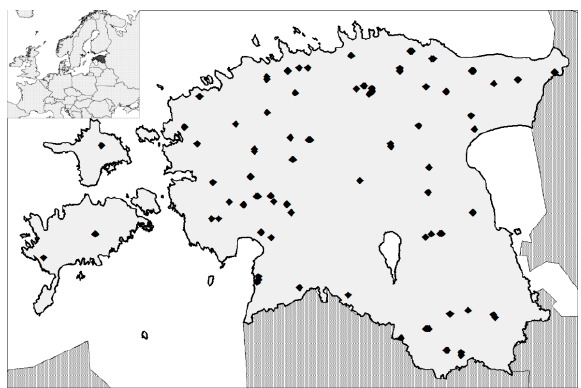
Figure 1. Locations of the studied abandoned extracted peatlands in Estonia (overall centroid: 58º 41' 42'', 25º 25'